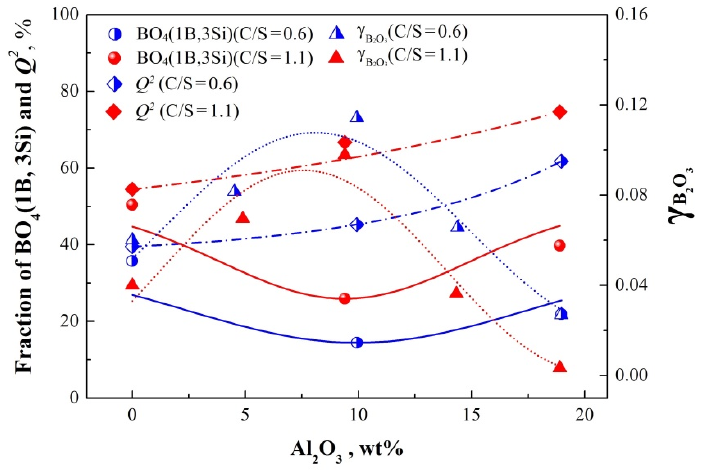
Figure 8. Comparison of the 𝛾 (cid:2886) value and structural units ( Q 2 and BO 4 (1B, 3Si)) under the con- dition of different Al 2 O 3 content and basicity.